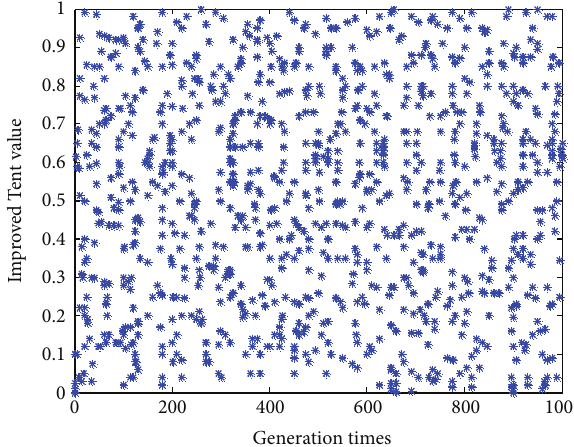
Figure 2: The chaos state of improved Tent mapping.